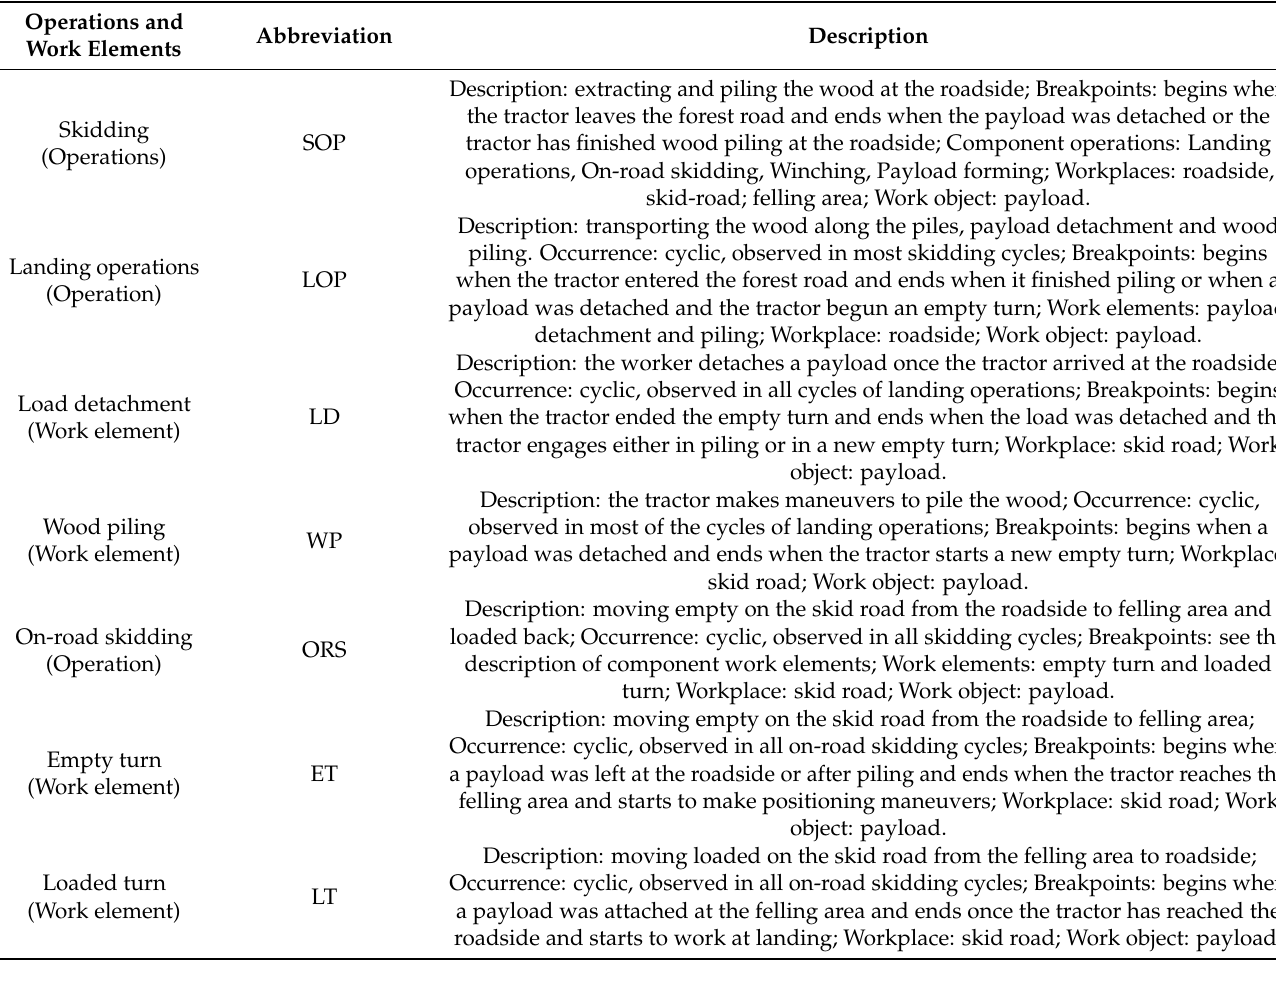
Table 3. Description of operations, work and time